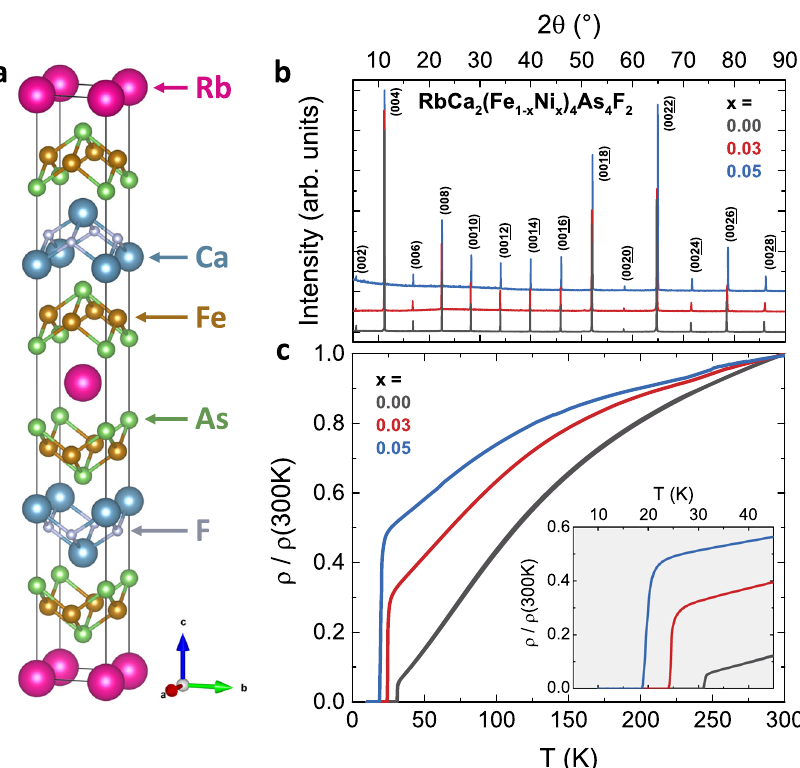
Fig. 1 Structure and basic properties of Rb-12442. a Ball-and-stick model of the RbCa 2 Fe 4 As 4 F 2 parent compound, as rendered by VESTA 57 . b X-ray diffraction patterns of the differently doped RbCa 2 (Fe 1 − x Ni x ) 4 As 4 F 2 single crystals studied in this work. c Temperature dependence of the resistivity, normalized by its value at 300 K, of the same single crystals. The inset shows a magni fi cation around the SC